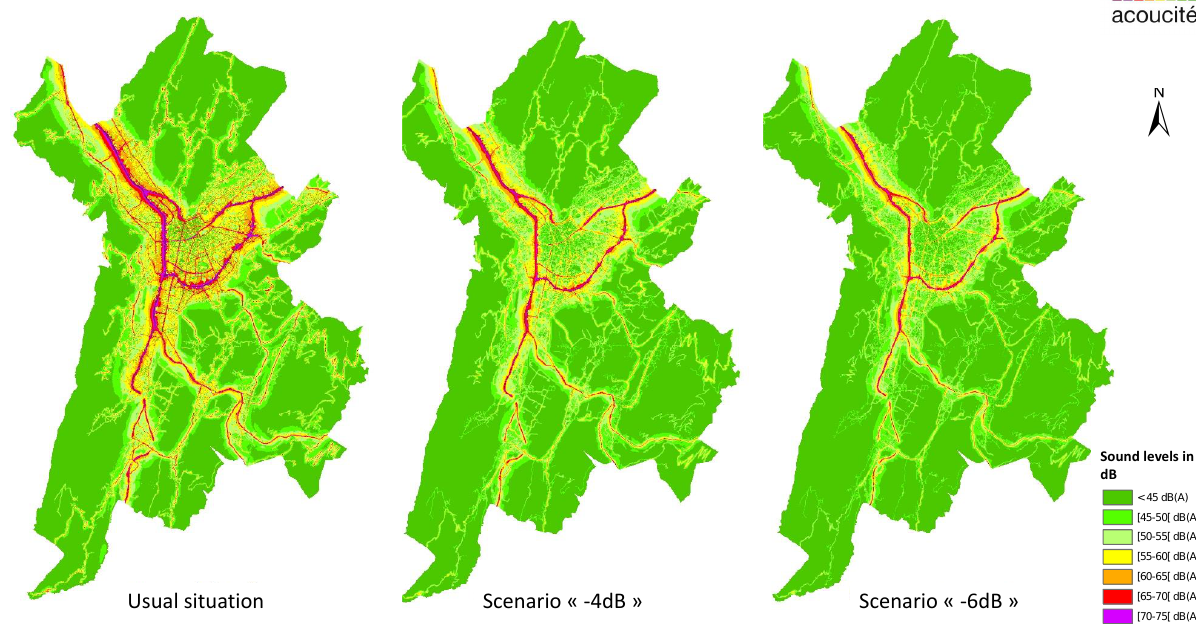
Figure 10: Road noise maps for the usual situation (left) and the scenarios “ − 4 dB” (middle) and “ − 6 dB” (right) for the Metropolis of Grenoble-Alpes (0.4 million inhabitants)